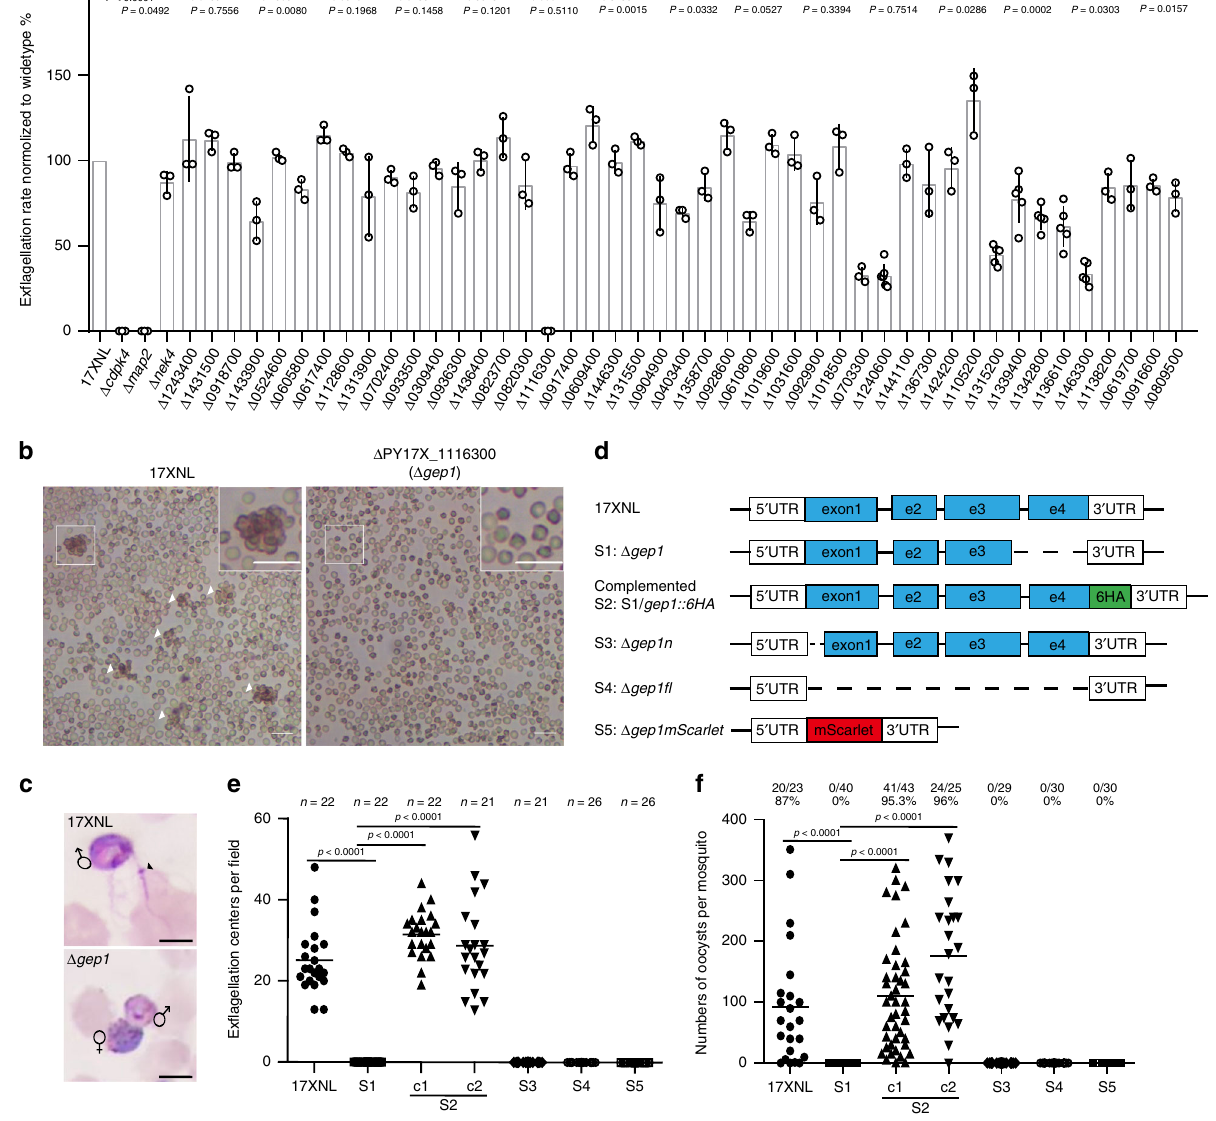
Fig. 1 Membrane proteins screening identi fi ed gep1 essential for gametogenesis. a In vitro XA stimulated ex fl agellation rates for P. yoelii 17XNL wild type (WT) and 45 mutant strains each with a speci fi c gene disruption. The ex fl agellation rate of each mutant was normalized with that of WT parallelly tested each time. The numbers for the gene name are the gene IDs derived in PlasmoDB. Data are shown as mean ± SD from n = 3 independent experiments for strains except n = 5 for Δ 1315200 , Δ 1339400 , Δ 1342800 , Δ 1366100 and Δ 1463300 , and n = 6 for Δ 1240600 . b Representative images of XA stimulated ex fl agellation centers (ECs, white arrows) under light microscope (10×). Scale bar = 20 μ m. c Images of the ex fl agellated male gametes (Black arrow) after Giemsa staining under light microscope (100×). Scale bar = 5 μ m. d Diagrams of WT gep1 gene structure and various mutants: S1 ( Δ gep1 ), deletion in C-terminus; S2 ( Δ gep1/gep1::6HA ), reconstructed gep1 with a 6HA tag; S3 ( Δ gep1n ), deletion in N-terminus; S4 ( Δ gep1 fl ), deletion of the full coding region; S5 ( Δ gep1mScarlet ), coding region replaced with mScarlet gene. e XA-stimulated EC counts from WT and the gep1 mutants. c1 and c2 are two clones of S2 parasite. n is the numbers of microscopic fi elds counted (40×). f Oocyst counts from WT and the gep1 mutants. Oocysts are counted from the mosquito midguts 7 days post blood feeding. x / y on the top is the number of mosquito containing oocyst/the number of mosquito dissected; the percentage number is the mosquito infection prevalence. Experiments were independently repeated six times in b , and three times in c , e , and f . Two-tailed unpaired Student ’ s t test was applied in a , e , and f . Source data of a , e , and f are provided as a Source Data fi TMs (Fig. 2a). Previous transcriptomic study indicated the gep1 protein is expressed in gametocytes and ookinetes, but not in gene is transcribed in gametocytes and ookinetes, but not asexual asexual blood stages and other mosquito stages of the 6HA :: gep1 blood stages of P. falciparum and P. berghei 19,20 . To investigate parasite (Fig. 2b, c). We also tagged the GEP1 protein with protein expression and localization, we tagged the endogenous quadruple Myc (4Myc) (Supplementary Fig. 1j, Supplementary GEP1 with 6HA at N-terminus (Supplementary Fig. 1g, j), gen- Fig. 5b) and observed similar expression pattern in the 4Myc :: gep1 erating 6HA :: gep1 parasite that had normal development parasite (Fig. 2d). In addition, mScarlet fl uorescent signals driven throughout the life cycle (Supplementary Fig. 5a). The GEP1 by the endogenous gep1 promoter were detected only in